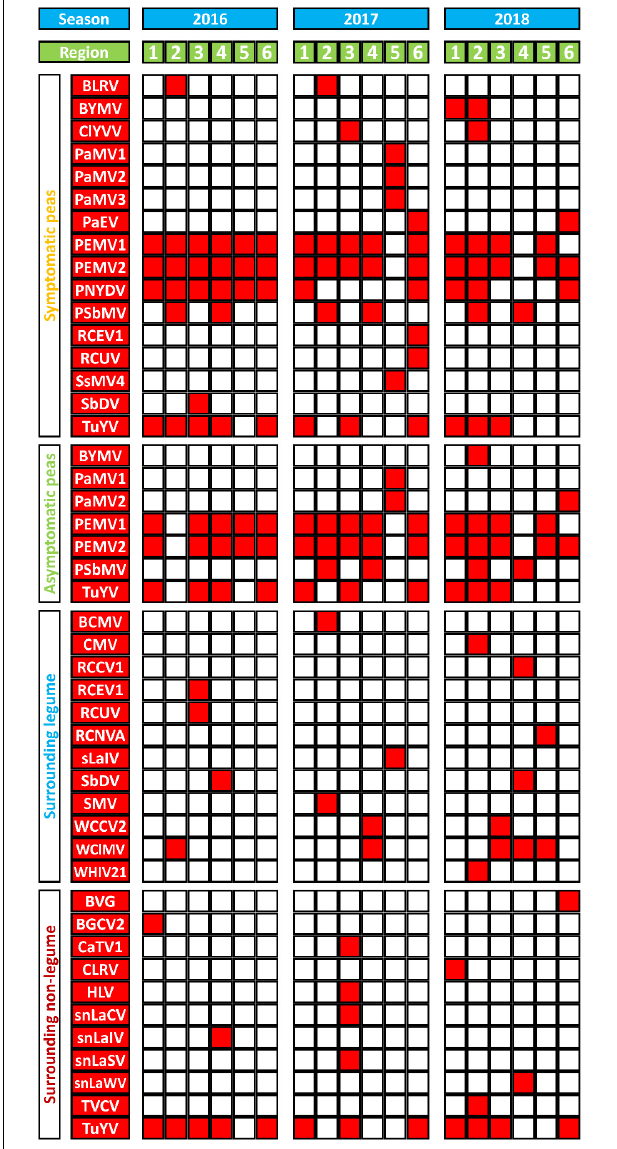
FIGURE 3 | A summary of virus species (in red) detected in and around sampled pea crops from six different German pea-growing regions (Salzlandkreis-1 [1], Salzlandkreis-2 [2], Münster [3], Kreis Stormarn [4], Landkreis Rostock [5], and Landkreis Meißen [6]) over three seasons 2016, 2017, and 2018. Virus acronyms, virus names, and their associated nucleic acids: BVG, barley virus G; BCMV, bean common mosaic virus; BLRV, bean leafroll virus; BYMV, bean yellow mosaic virus; BGCV2, black grass cryptic virus 2; CaTV1, carrot torradovirus 1; CLRV, cherry leaf roll virus; ClYVV, clover yellow vein virus; CMV, cucumber mosaic virus; HLV, Heracleum latent virus; PaMV1, pea associated mitovirus 1; PaMV2, pea associated mitovirus 2; PaMV3, pea associated mitovirus 3; PaEV, pea associated emaravirus; PEMV1, pea enation mosaic virus 1; PEMV2, pea enation mosaic virus 2; PEMVsatRNA, pea enation mosaic virus satellite RNA; PNYDVaSat1, pea necrotic yellow dwarf alphasatellite 1; PNYDVaSat3, pea necrotic yellow dwarf alphasatellite 3; PNYDVaSat4, pea necrotic yellow dwarf alphasatellite 4; PNYDVaSat5, pea necrotic yellow dwarf alphasatellite 5; PNYDVaSat6, pea necrotic yellow dwarf alphasatellite 6; PNYDVaSat7, pea necrotic yellow